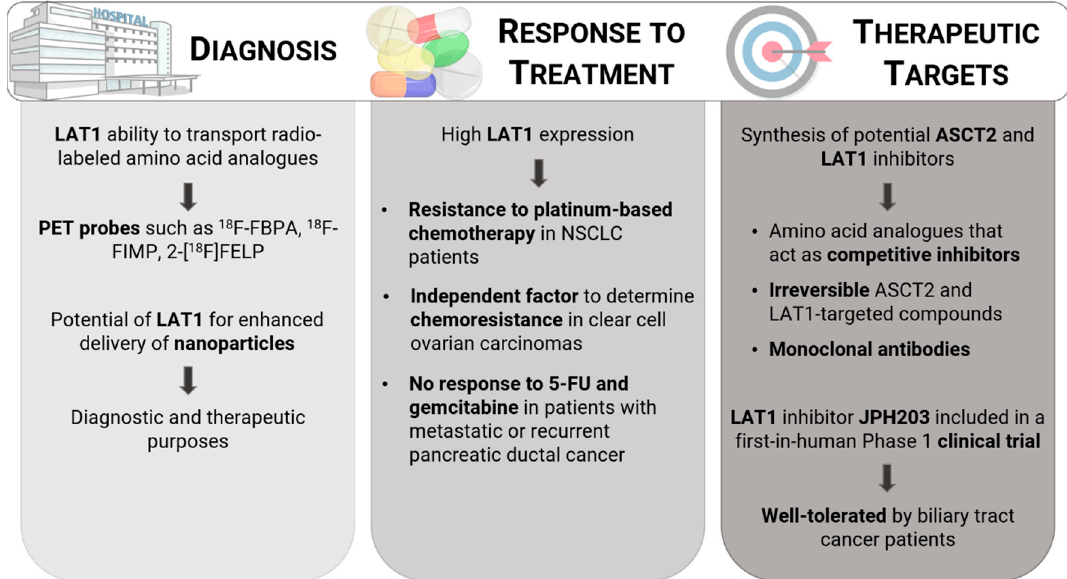
Figure 5. Clinical significance of ASCT2 and LAT1. LAT1 has been used in the clinic for diagnostic purposes due to its ability to transport PET probes and enhance nanoparticles delivery. Moreover, high LAT1 expression has been associated with chemoresistance in some types of cancer. ASCT2 and LAT1 have also been identified as therapeutic targets, with some studies reporting the successful synthesis of potential competitive or irreversible inhibitors of these transporters, as well as the use of monoclonal antibodies.